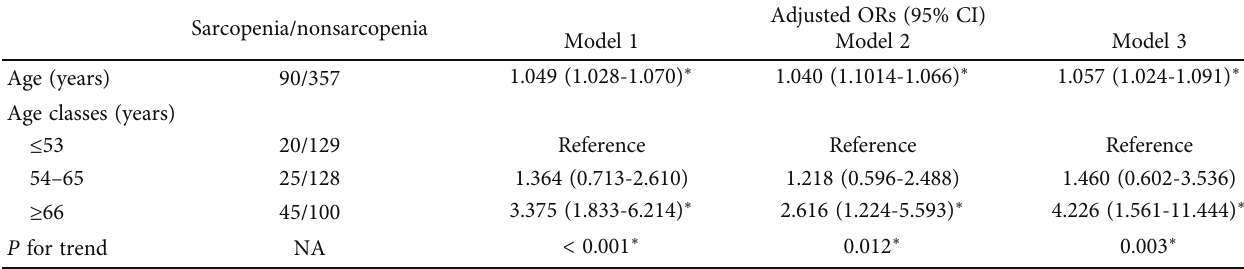
Table 2: Multivariate logistic regression models for increased ages and higher prevalence of sarcopenia.